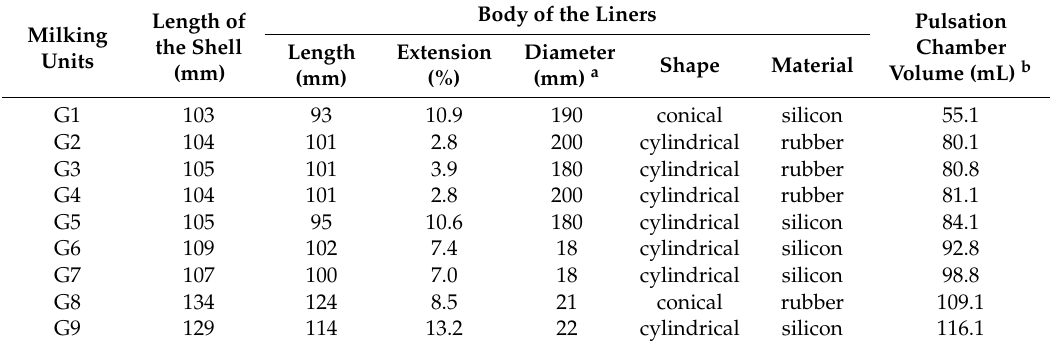
Table 1. Main characteristics and dimensions of the milking units adopted in the research trials. Milking